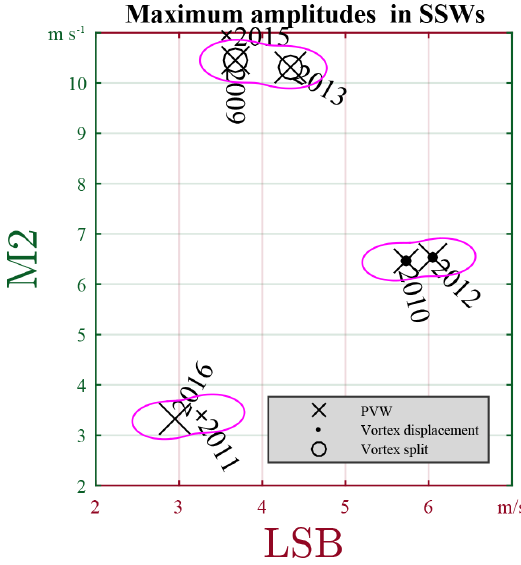
Figure 5. Scatterplots of the maximum amplitudes of LSB and M2 during SSWs, read from Fig. 3. The size of the cross is proportional to the PVW strength defined by Zhang et al. (2014). The magenta circles cluster the PVWs into three main groups according to the SSW classification according to the associated polar vortex split or